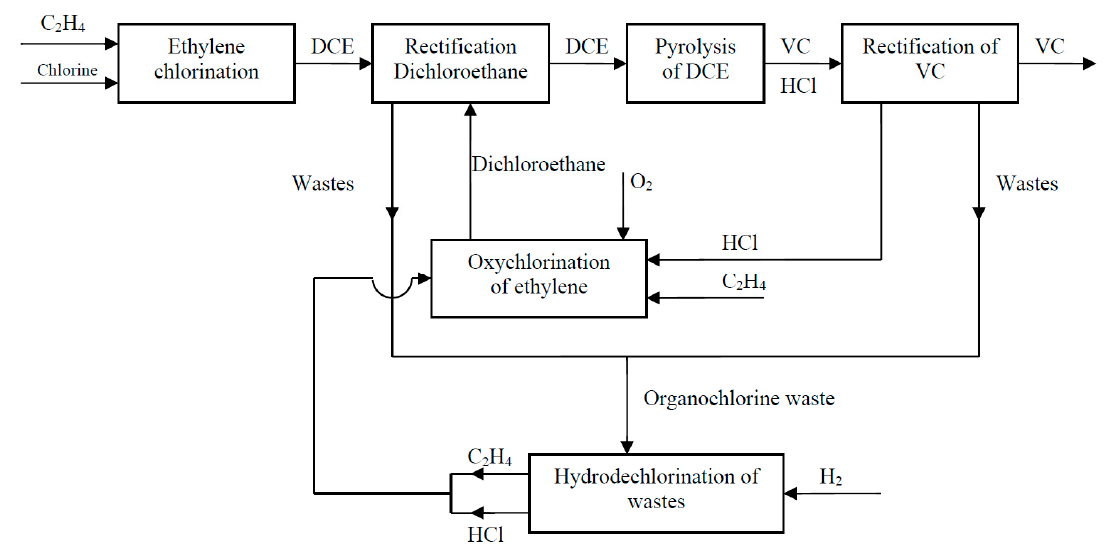
Figure 2. Obtaining vinyl chloride from ethylene according to a balanced scheme with the stage of waste hydrodechlorination.